Question: Briefly state, in one sentence, what is plotted here.
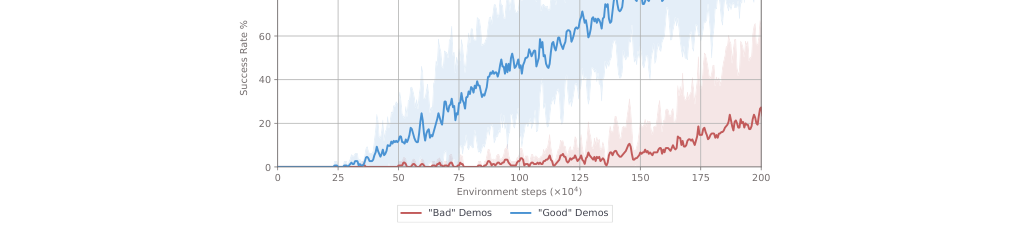
Answer: ManiSkill2 PegInsertion results with fixed demonstration sets. ”Bad” Demos correspond to runs using the only set of demonstrations that led to no success in the main results in Fig. 4. ”Good” Demos is randomly chosen to be one of the other set of demonstrations used in the main results. Results averaged over 5 seeds with shaded area representing 95% CIs.